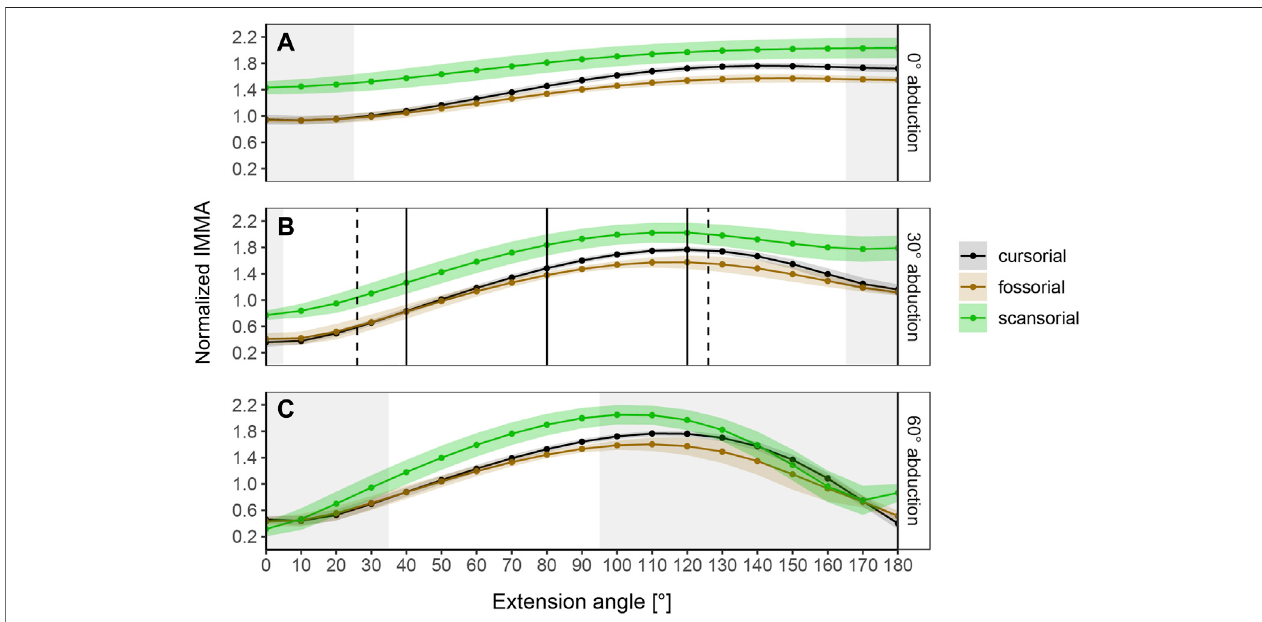
FIGURE4| CurveprogressionsofnormalizedIMMAlengthsaveraged(±S.E.)perlifestylecategory.Thenormalized IMMAwasobtainedbydividingtheIMMA[cm] by the anteroposterior diameter of the femoral midshaft of the species. Gray areas depict extension angles that are anatomically impossible due to bone collisions in at least one specimen of the dataset. (A) Measurement series at 0 ° abduction. (B) Measurement series at 30 ° abduction. Solid black vertical lines mark the three extension angles (40 ° , 80 ° , and 120 ° ) used for macroevolutionary modeling. Dashed vertical lines mark the touchdown (26 ° ) and lift-off (126 ° ) extension angles of the small caviomorph rodent G. musteloides ( in vivo data from Fischer et al., 2002). (C) Measurement series at 60 ° abduction.